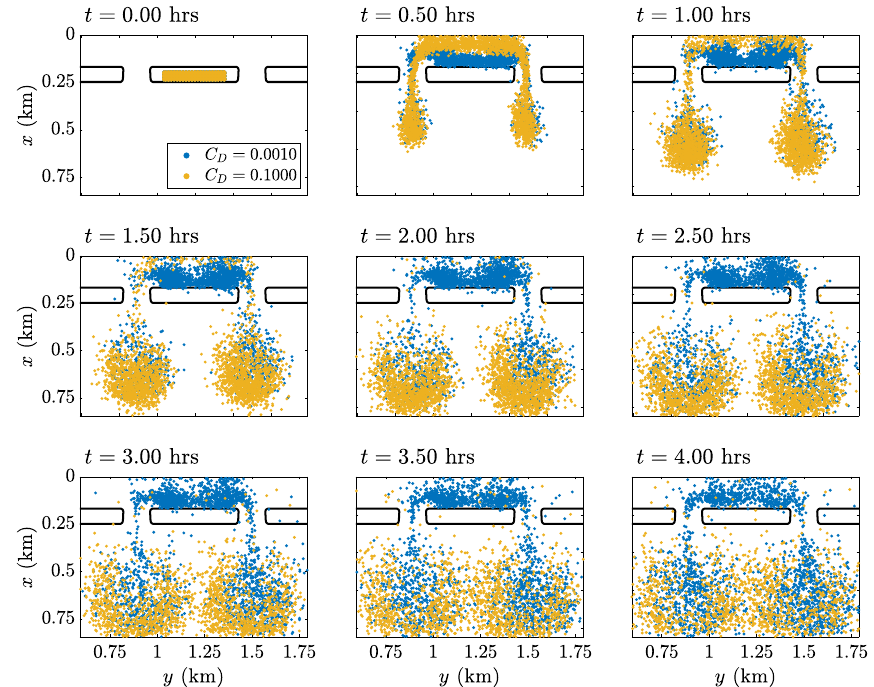
Figure 5. Particle locations at half hour intervals, initiated an hour before high tide. Blue markers: C D = 0.001 reef flat roughness, yellow markers: C D = 0.1 reef flat roughness. Here, K h = 0.5m 2 / s , see Supplementary Materials Figs. 1 and 2 for the same calculation carried out with K h = 0.1m 2 / s and K h = 1 m 2 / s